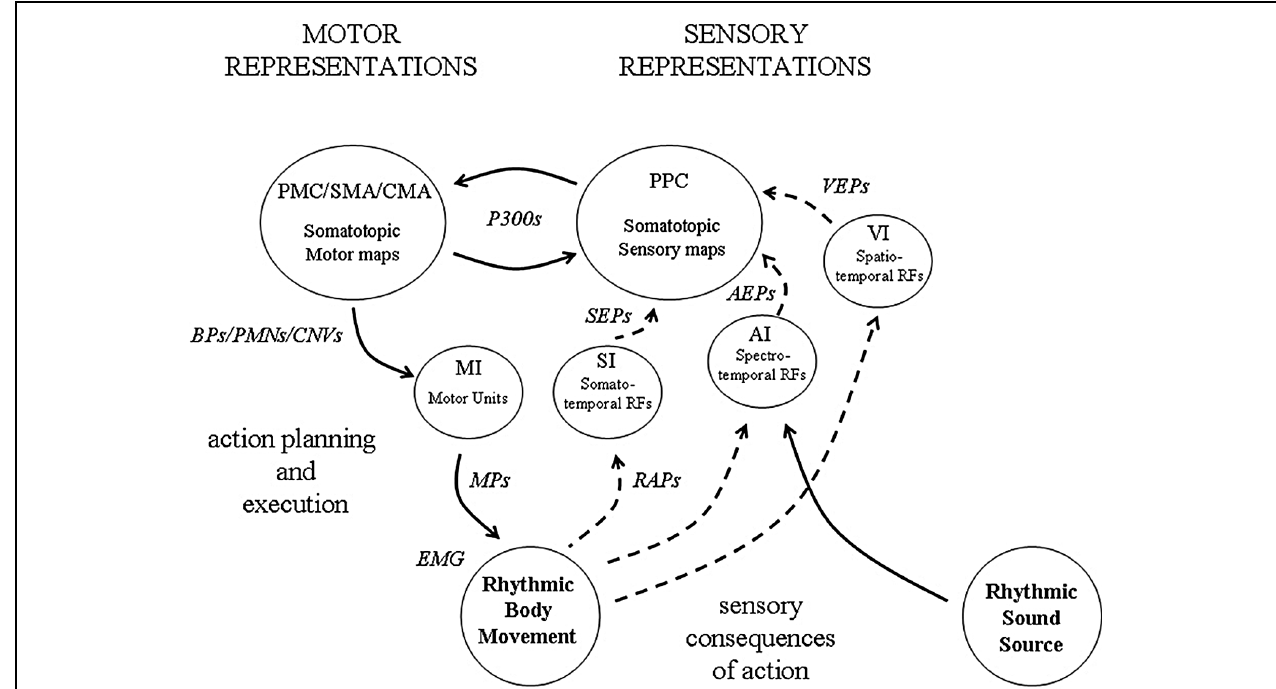
FIGURE 1 | An illustration of how sensory and motor representations may interact during beat induction. Neuronal observables are indicated in italic. At the level of the sensory cortex (i.e., AI, VI, SI), receptive fields (RFs) tuned to features of the sensory (i.e., auditory, visual, somatosensory) input represent temporal regularity in the form of a kind of wavelet transform (a form of constant-Q modulation spectrogram). At a macroscopic level, the collective response of populations of such RFs underlies observed evoked potentials (EPs), (i.e., AEPs, VEPs and SEPs ). At the lowest level in motor cortex (MI) somatotopic representations of